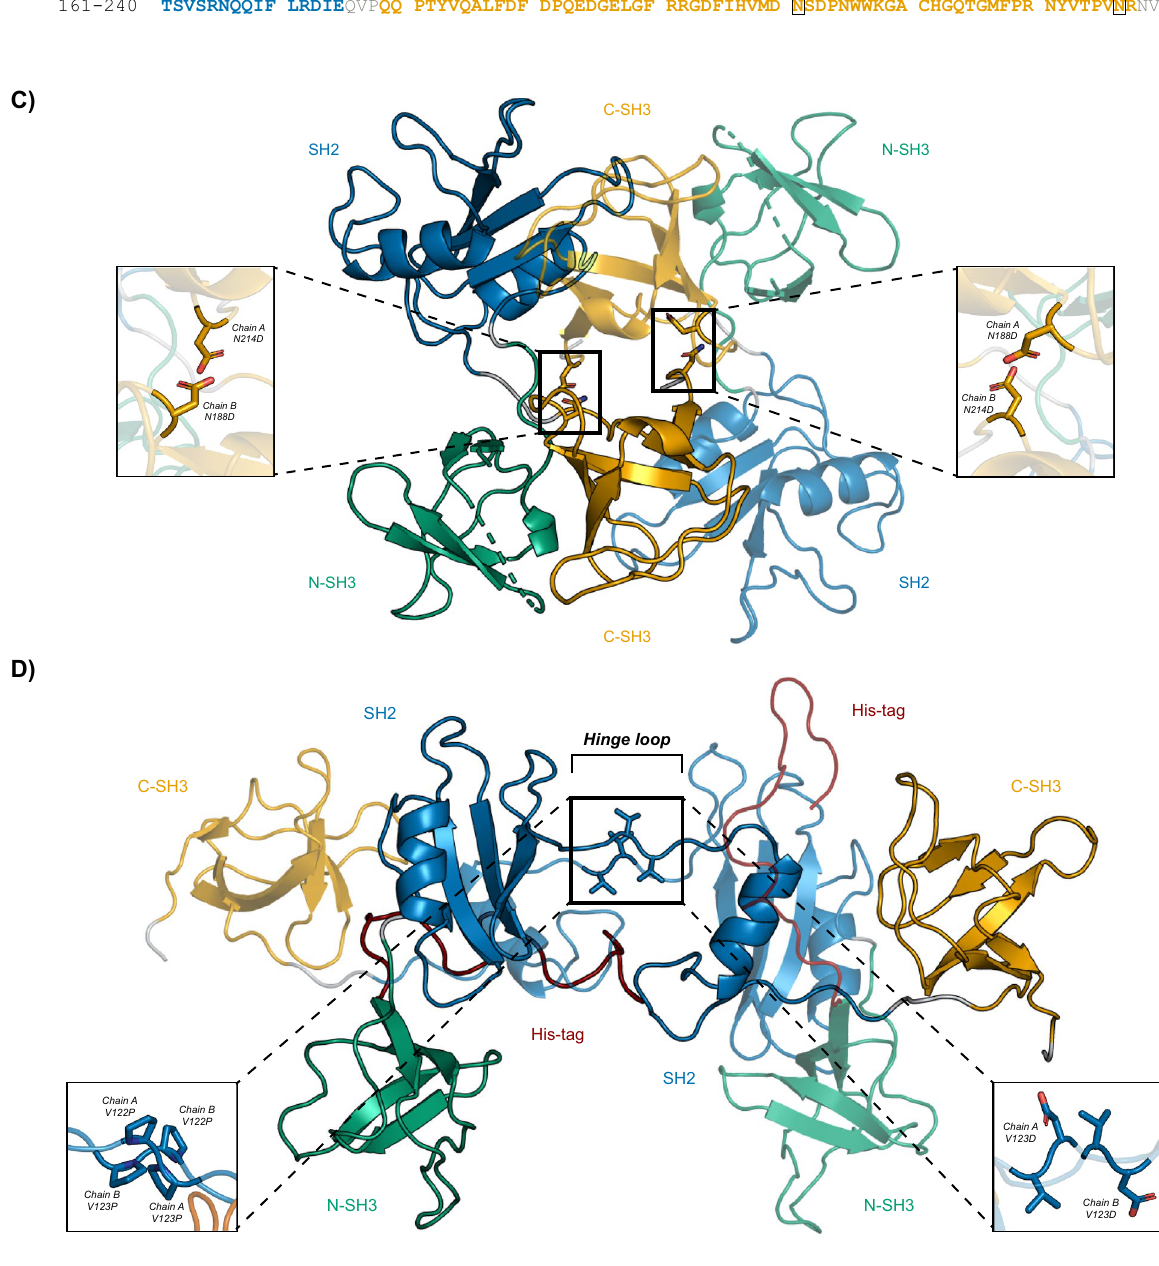
Figure 1. Structural models of full-length human wild-type GRB2. ( A ) A schematic is shown depicting the domain organization of full-length GRB2 with corresponding amino acid numbering. N-terminal SH3, central SH2, and C-terminal SH3 domains are shown in green, blue, and orange, respectively. ( B ) The amino acid sequence of recombinant His-tagged GRB2 is shown with segments colored as in the schematic shown in Panel A with linkers in grey and poly-histidine-tag in red. Residues targeted for mutation are boxed in black. ( C ) Ribbon representation of a GRB2 dimer crystal structure (PDB: 1GRI) with SH2/C-SH3-mediated domain- swapping. One protomer is depicted partially transparent for contrast. Inset shows conversion of native N188 and N214 sites to Asp residues as mutations reported to abolish dimerization. ( D ) Ribbon representation of the proposed SH2/SH2-mediated domain- swapped dimer model with C-terminal α-helix segment exchanged developed from a combination of an SH2/SH2 domain-swapped dimer consisting of the isolated SH2 domain (PDB: 6ICH) supplemented with the N- and C–SH3 domains derived from the full length GRB2 crystal structure (PDB: 1GRI). Insets show the V122P/V123P mutation to induce dimerization (left) and the V123D mutation to abolish dimerization (right). Images were generated by the authors using